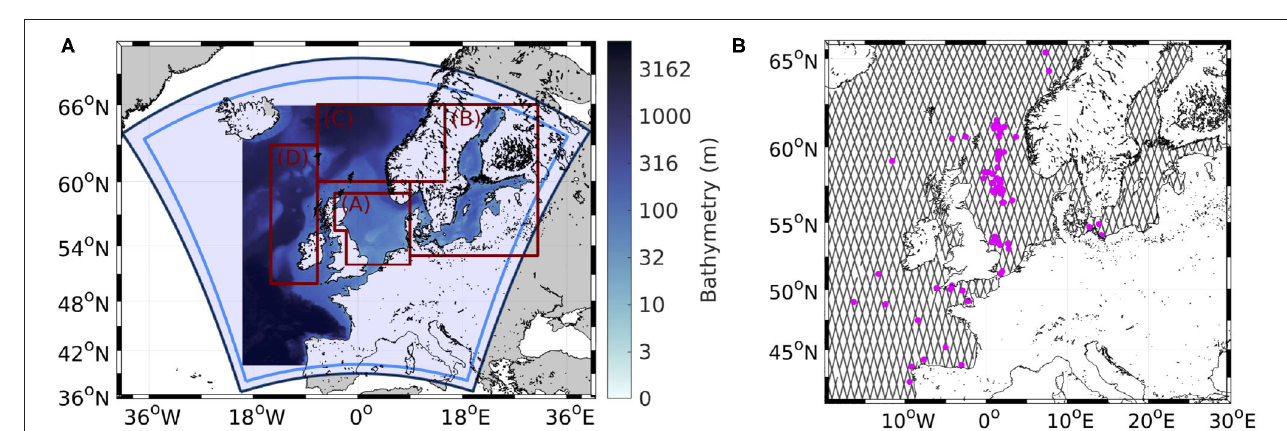
FIGURE 1 | Bathymetry of the wave model WAM (shaded) and domain of the CCLM regional climate model (dark blue box). The area between the dark and light blue boxes is regarded as the buffer zone and is neglected in the analysis. The four different study areas are indicated by the gray boxes in (A) the North Sea (A), the Baltic Sea (B), the southern Norwegian Sea (C), and the North Atlantic Ocean west of the British Isles (D). The locations of the GTS (magenta dots) and Sentinel-3A measurements (gray lines) are shown in (B) .